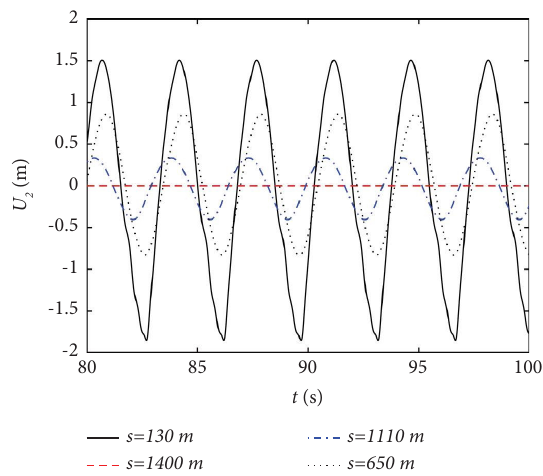
Figure 9: Time history of normal motion at A